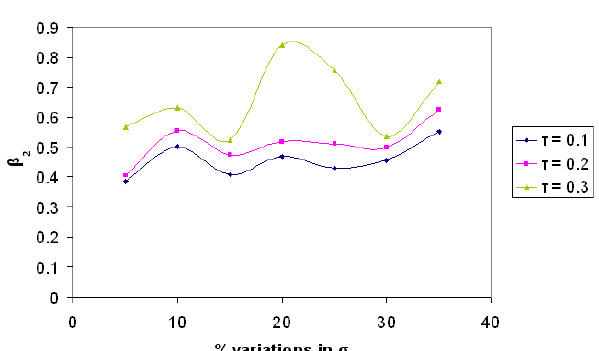
Figure 8. β 2 vs. % variations in τ .